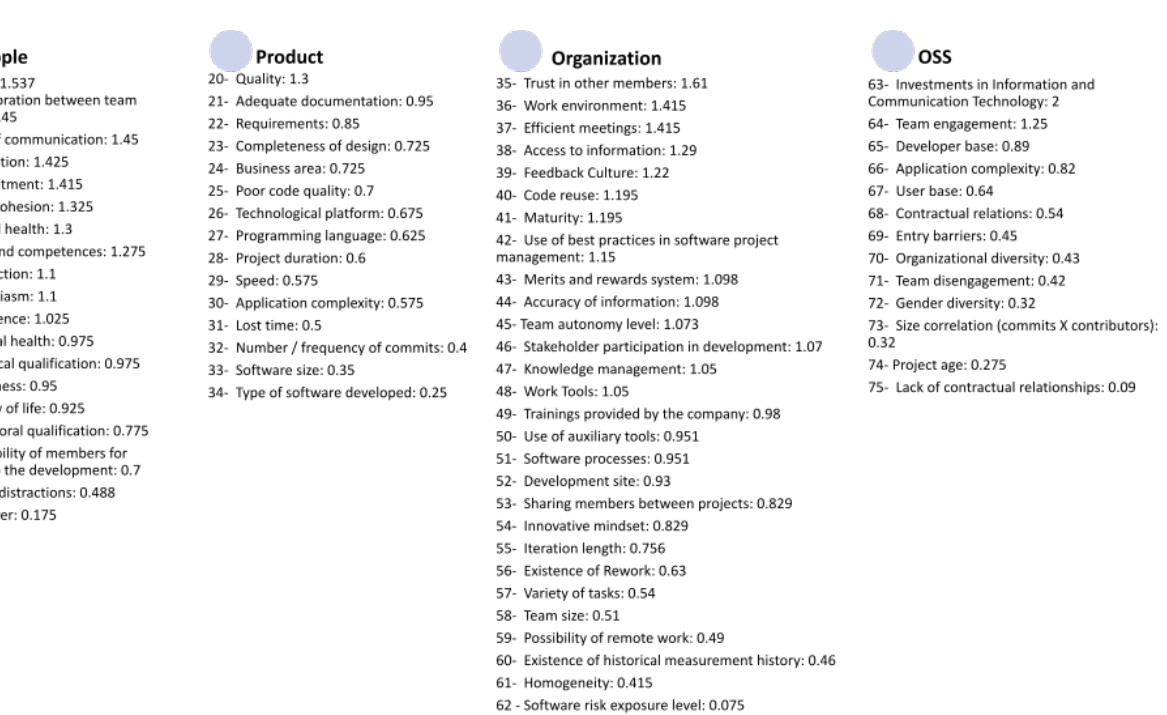
Figure 2. Factors that influence Productivity and their respective